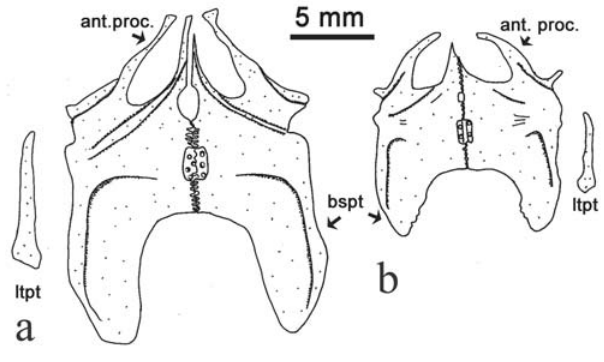
Fig. 5. Basipterygia (bspt), anterior processes (ant. proc.) and lateropterygium (ltpt), dorsal view. a. Parancistrus aurantiacus ; b. Parancistrus nudiventris